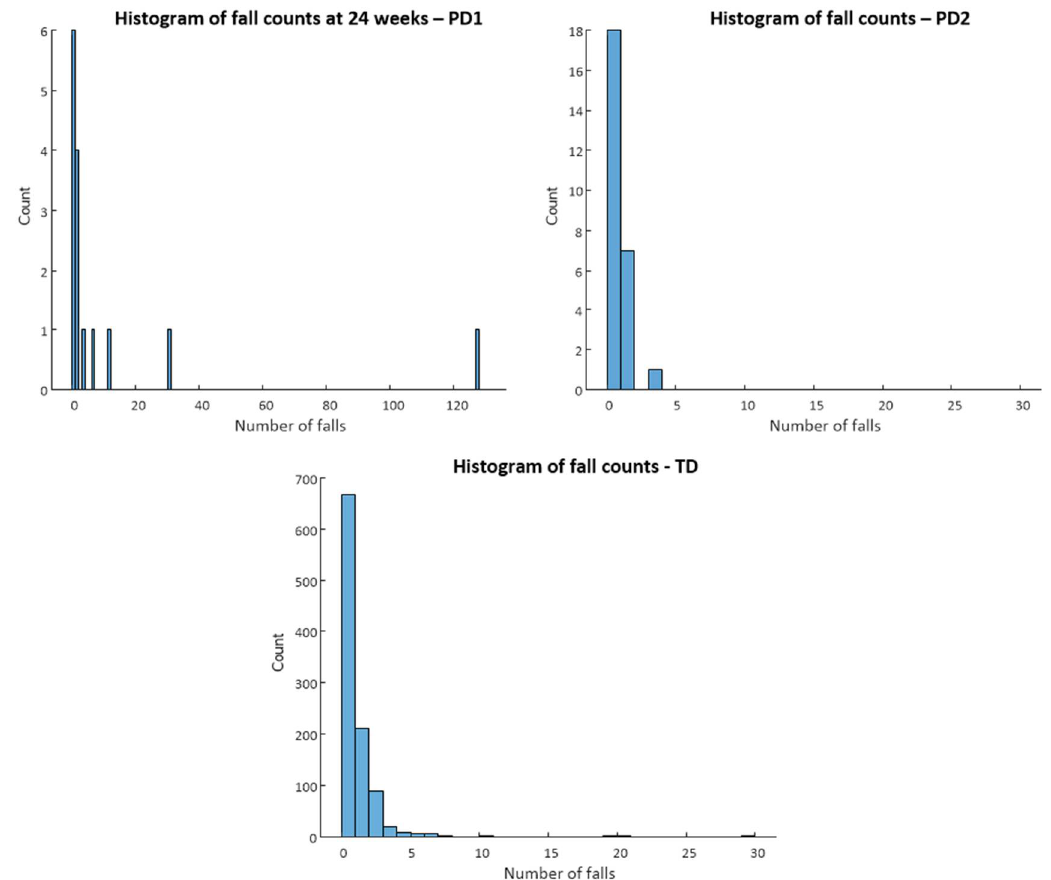
Figure 1. Histogram of falls counts for each dataset. Distributions are clustered around low numbers of falls, with a majority of participants in each dataset reporting no falls.